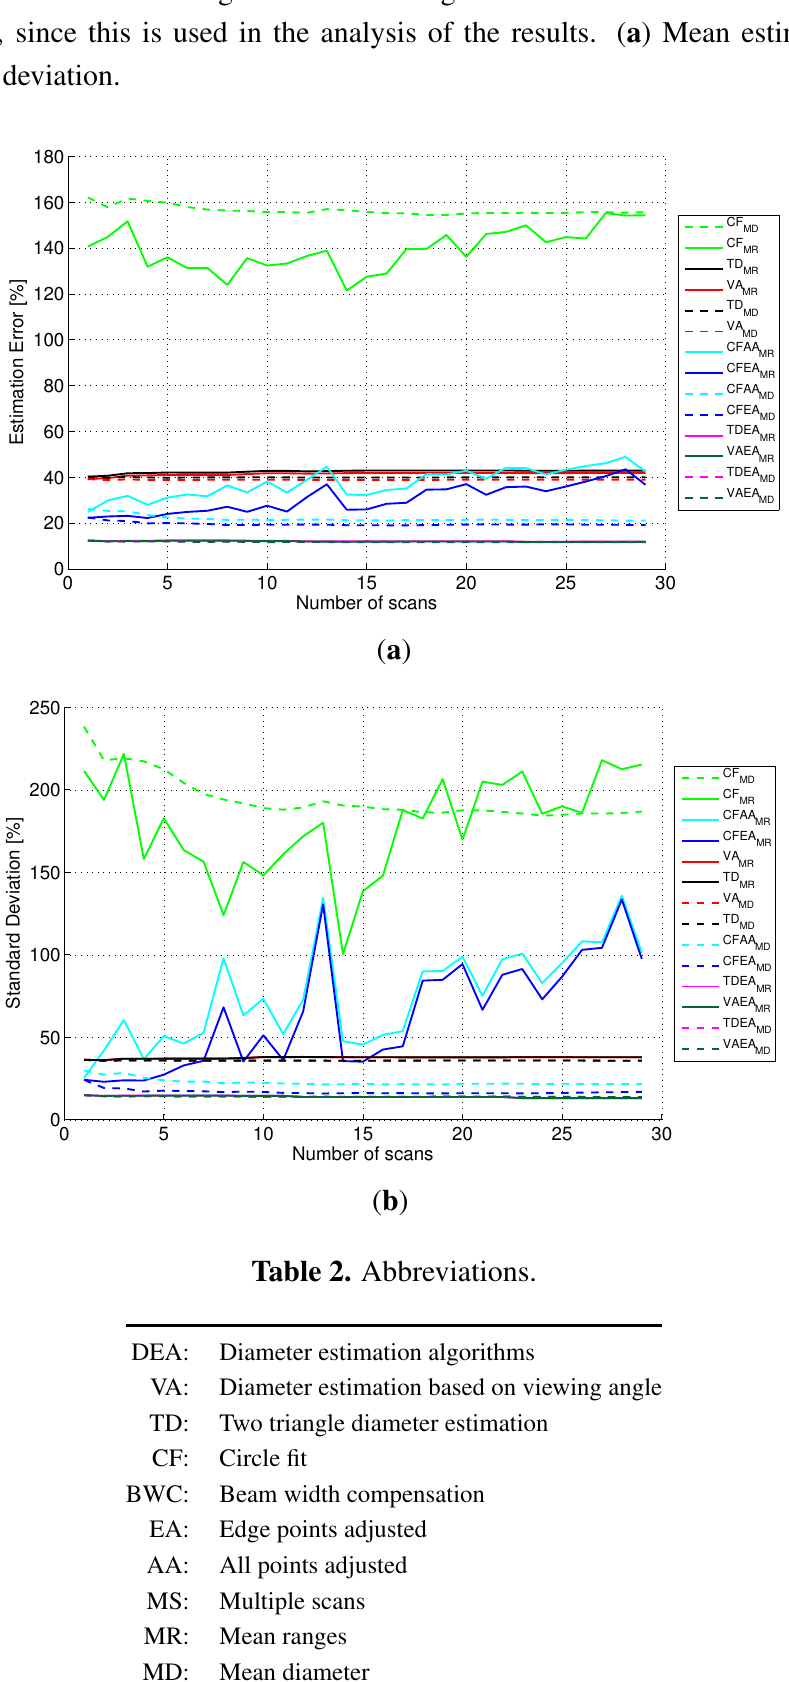
Figure 4. Mean absolute percentage estimation error and standard deviation as a function of number of scans for 14 algorithms.